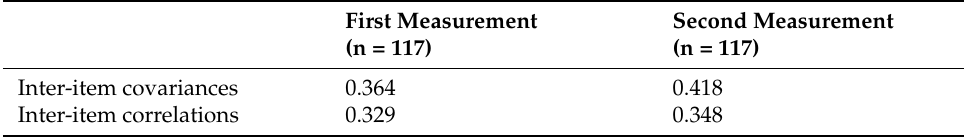
Table 3. Inter-item covariances and correlations in the